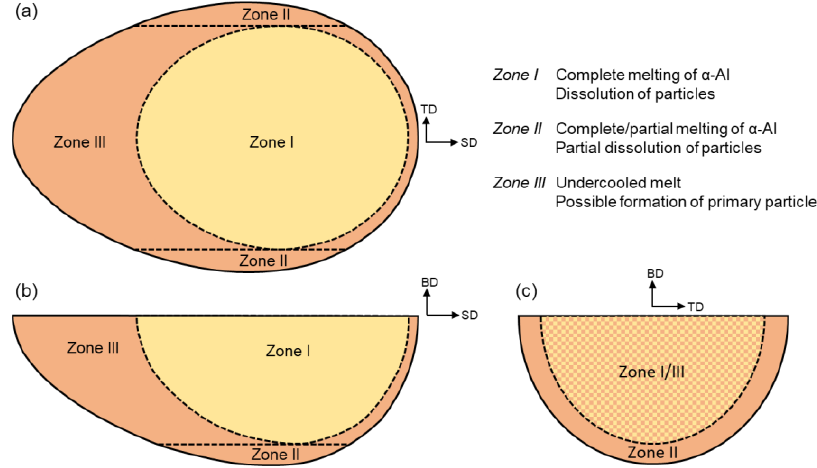
Figure 7. Schematic demonstration of different zones involved with particle evolution during heating and cooling by laser scanning: ( a ) top view, ( b ) TD cross-section, and ( c ) SD cross-section.